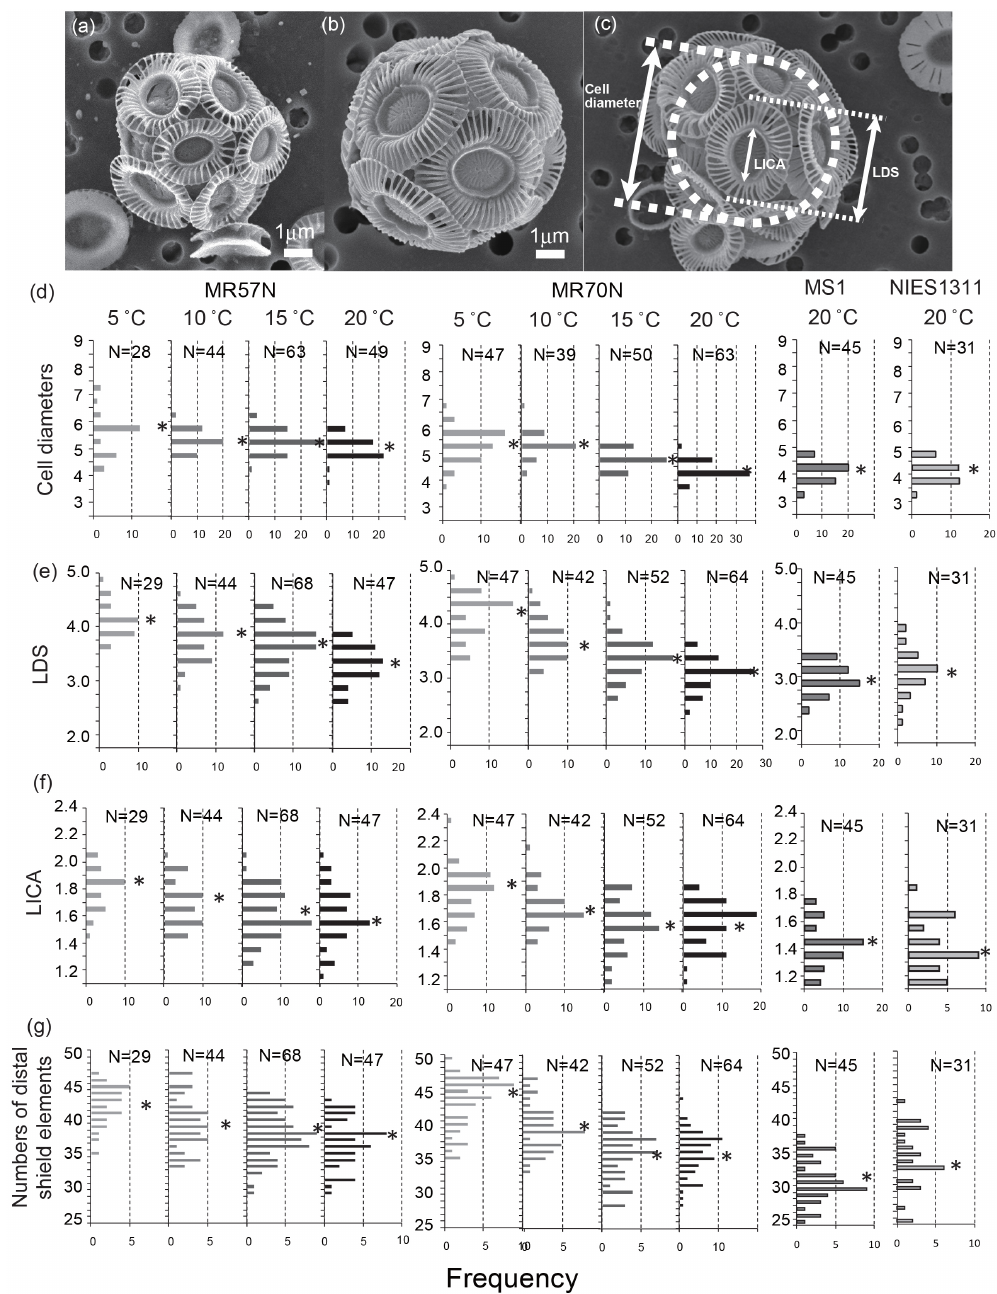
Figure 2. Effects of temperature on cell morphology. (a) SEM images of strain MR70N grown at 20 ◦ C; (b) SEM images of strain MR70N grown at 5 ◦ C. (c) Definitions of morphometric parameters of E. huxleyi cells: (d) cell diameter; (e) longer distal shield length (LDS); (f) long axis length of the inner central area (LICA); and (g) the numbers of distal shield elements in a coccolith. The MR1 and NIES1311 strains grown at 20 ◦ C were used as controls. Asterisk (*) and N indicate the average value of each histogram and the number of samples determined,